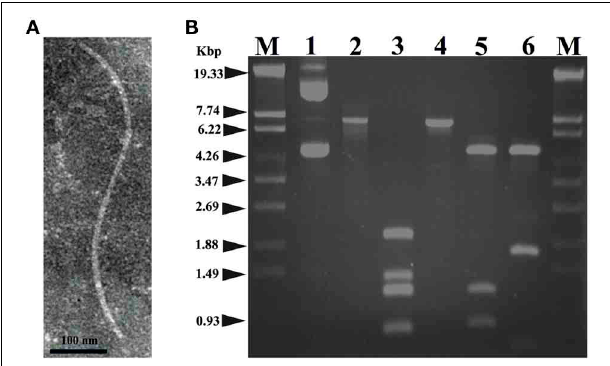
transmission electron microscopy. A filamentous structure was observed (approximately 600nm in length). (B) Restriction patterns of the replicative form of the XacF1 genomic DNA. Lanes: 1, undigested XacF1 DNA (RF); 2, digested with S1 nuclease; 3, Hin cII; 4, Eco RI; 5, Eco RV; 6, Cla I; M, λ Sty I